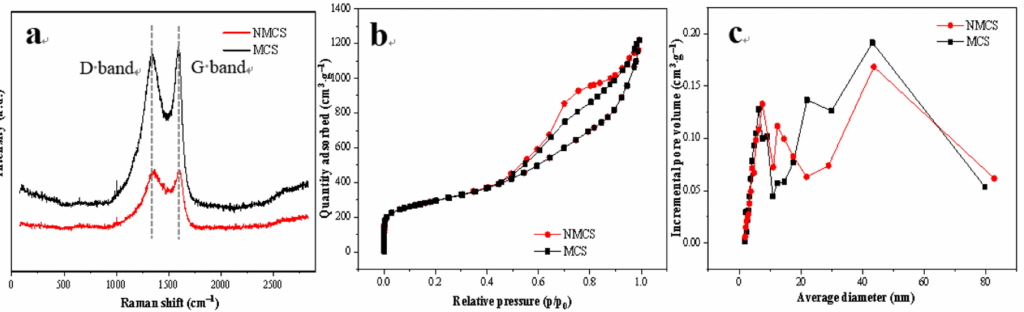
Figure 2. ( a ) Raman spectra of MCS and NMCS; ( b ) N 2 adsorption/desorption isotherms of MCS and NMCS; ( c ) pore size distribution curves of MCS and NMCS.